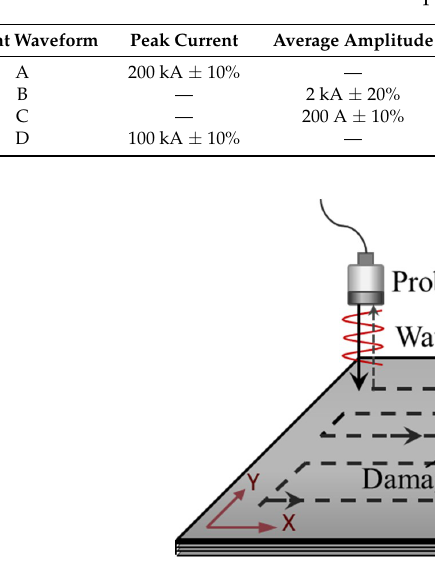
Figure 5. The ultrasonic C-scanning process.